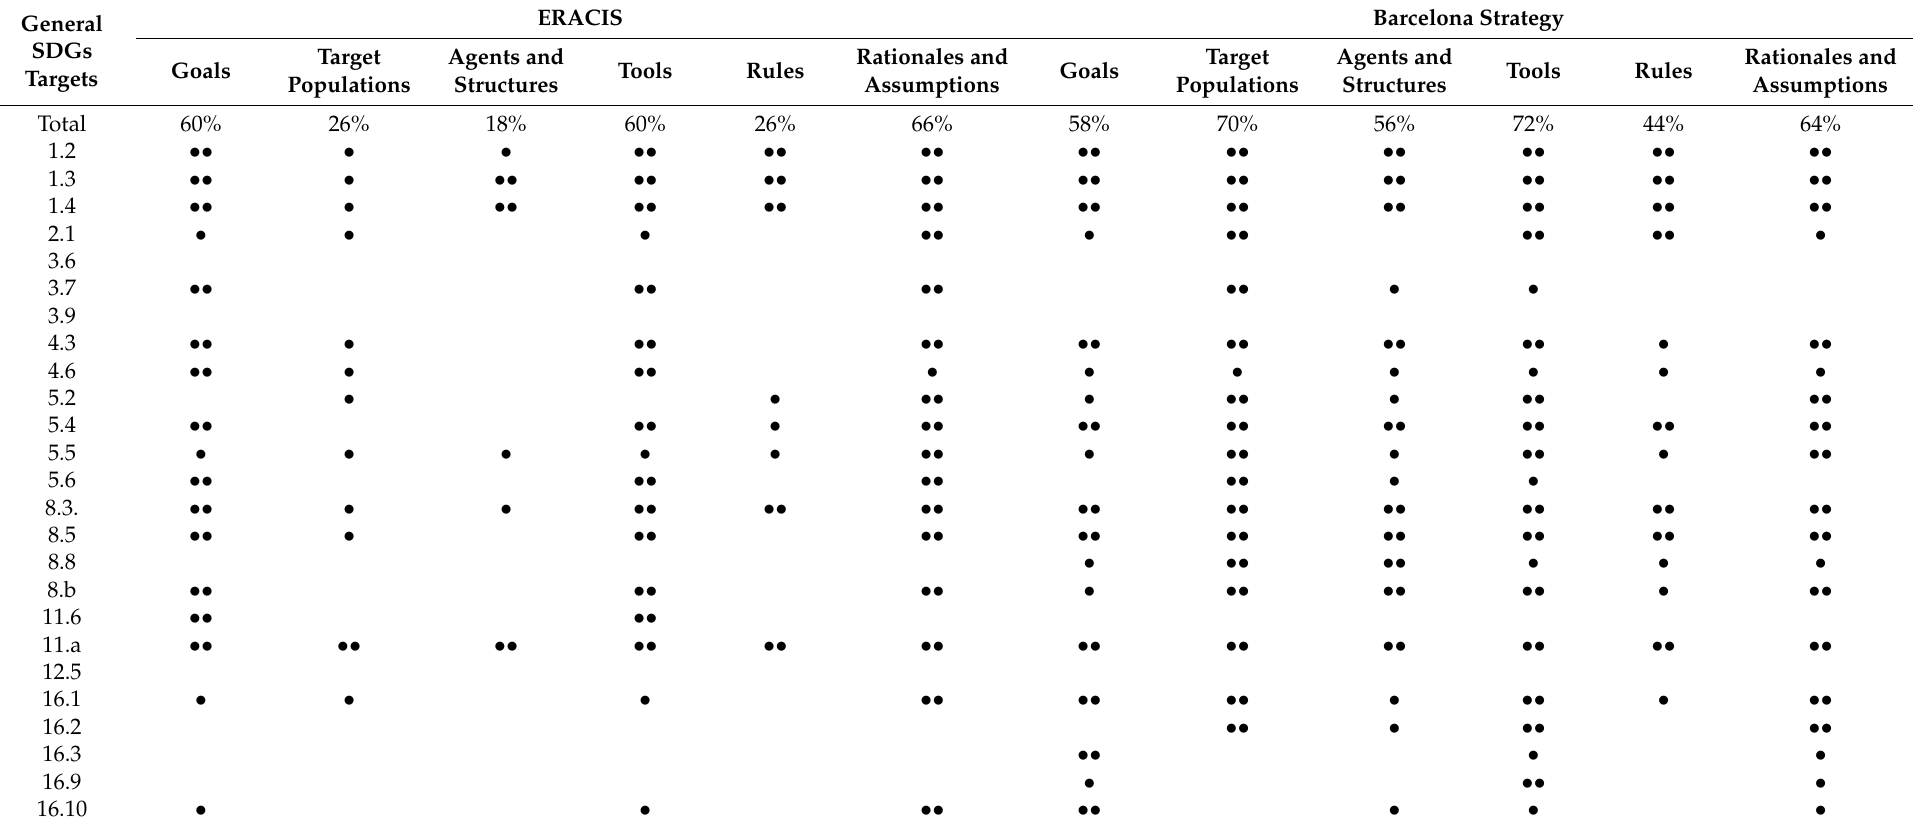
Table 2. General SDGs in ERACIS and Barcelona